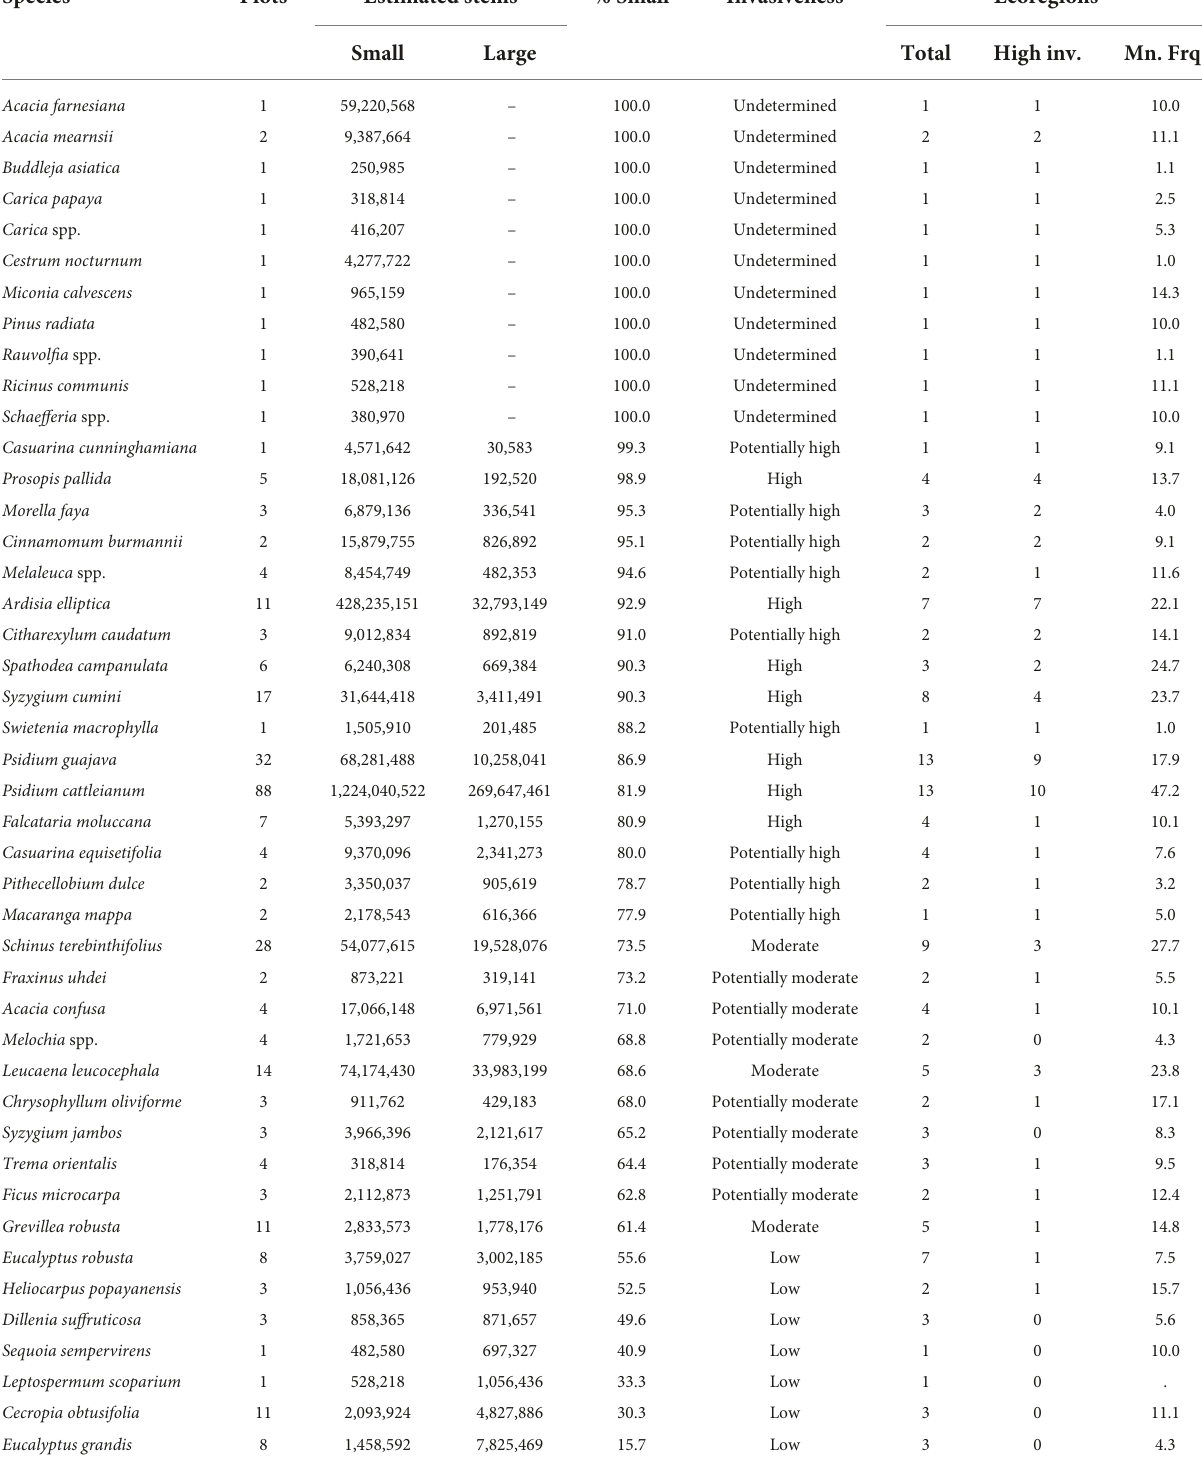
TABLE 2 Sixty-two non-native tree species detected by the Forest Inventory and Analysis (FIA) program in Hawaii, along with the number of plots on which each was inventoried, the estimated number of small and large stems based on the FIA sample design; the percent of all trees within the small tree size class; the overall invasiveness assigned to the species based on its proportion of smaller trees; and the total number of ecoregions on which each species was detected, the number of ecoregions where each species is highly invasive, and the mean frequency (percent of plots) on which the species occurs across the ecoregions in which it is